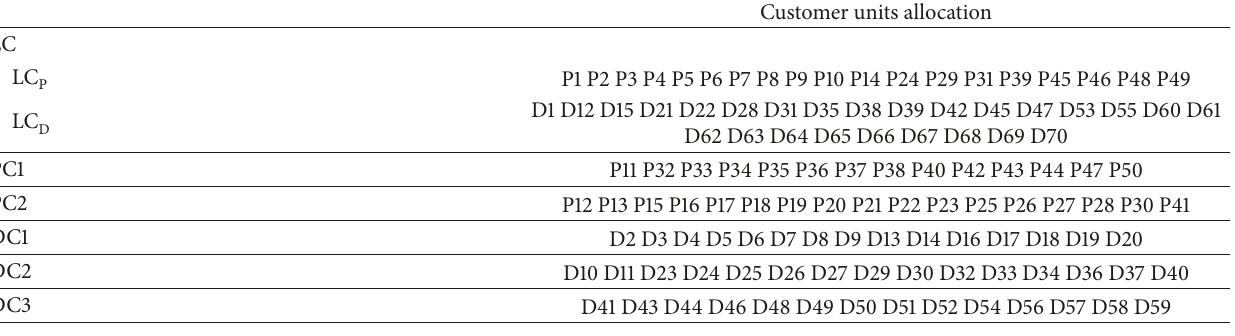
Table 5: Customer units’ assignment in the grand